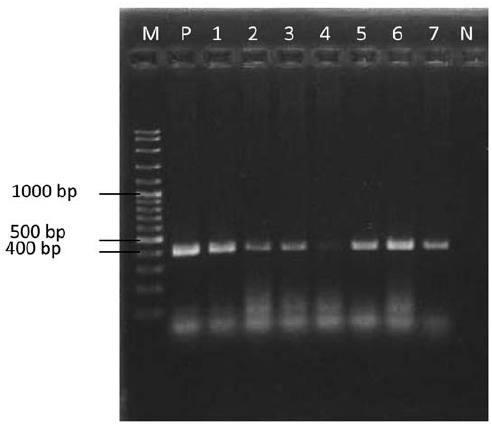
Figure 1. 1.5% agarose gel stained with ethidium bromide. Amplification of the 16S rRNA gene with CANIS/GA1UR primers,